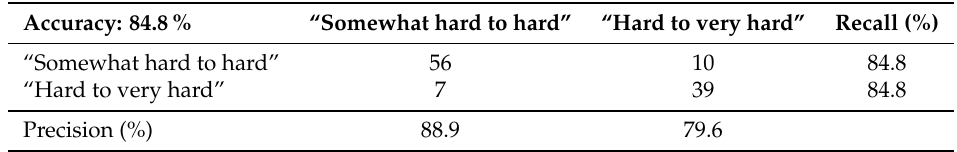
Table 3. Confusion matrix for the CNN classifiers. Each row represents the correct label (e.g., ground truth), whereas the columns display the predictions made by the network.